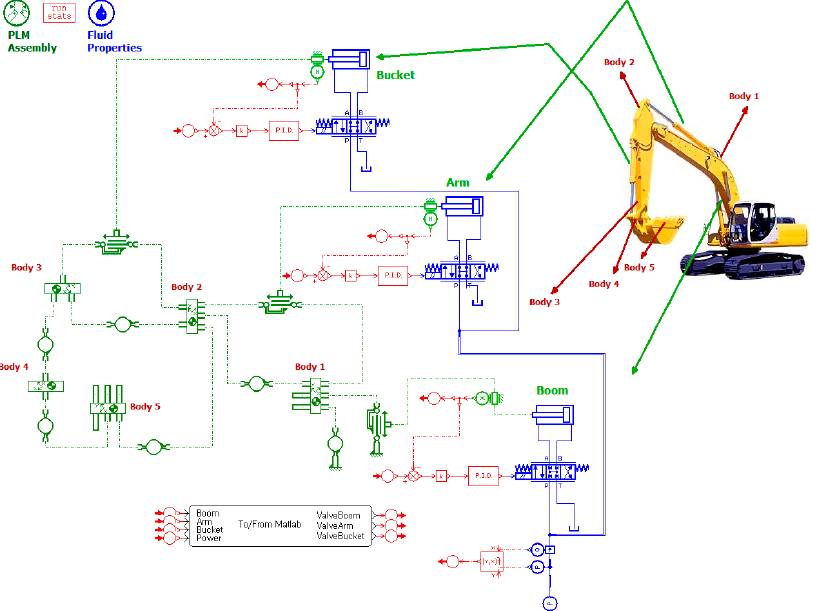
Figure 1. Excavator AMESim hydraulic model.